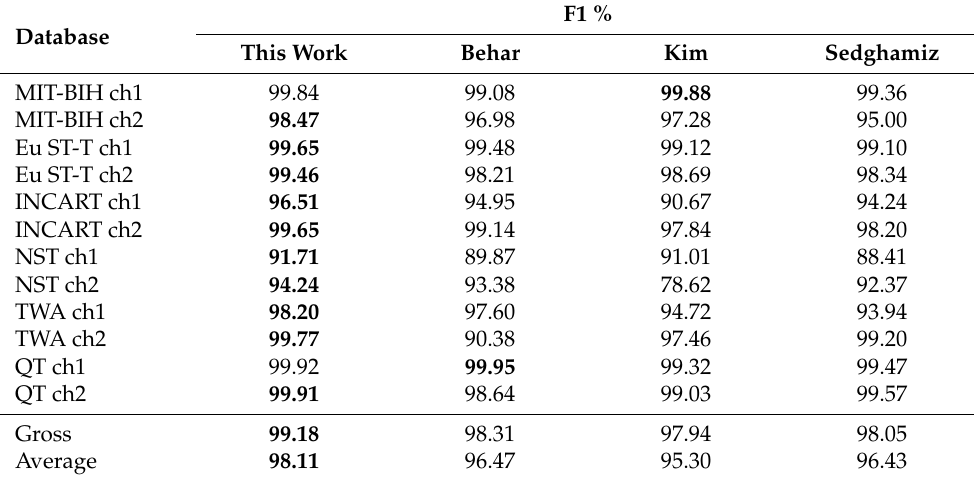
Table 2. QRS detection F1 score.